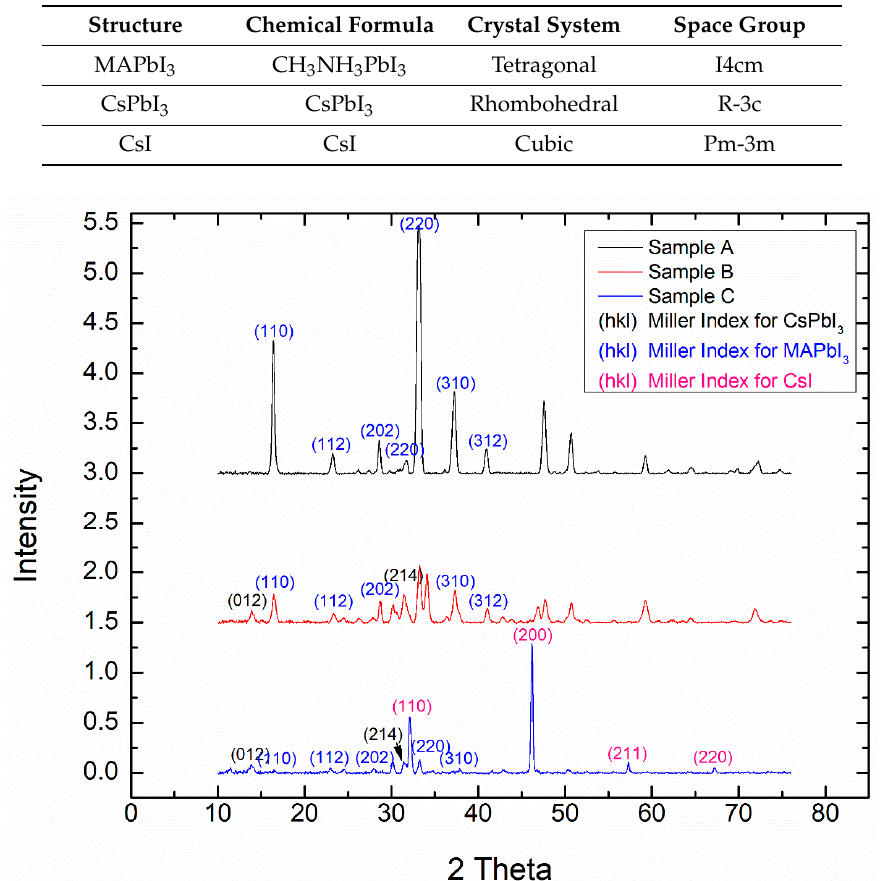
Figure 3. X-ray diffraction (XRD) results for sample A, B and C when compared to MAPbI 3 , CsPbI 3, and CsI (before water-treatment).